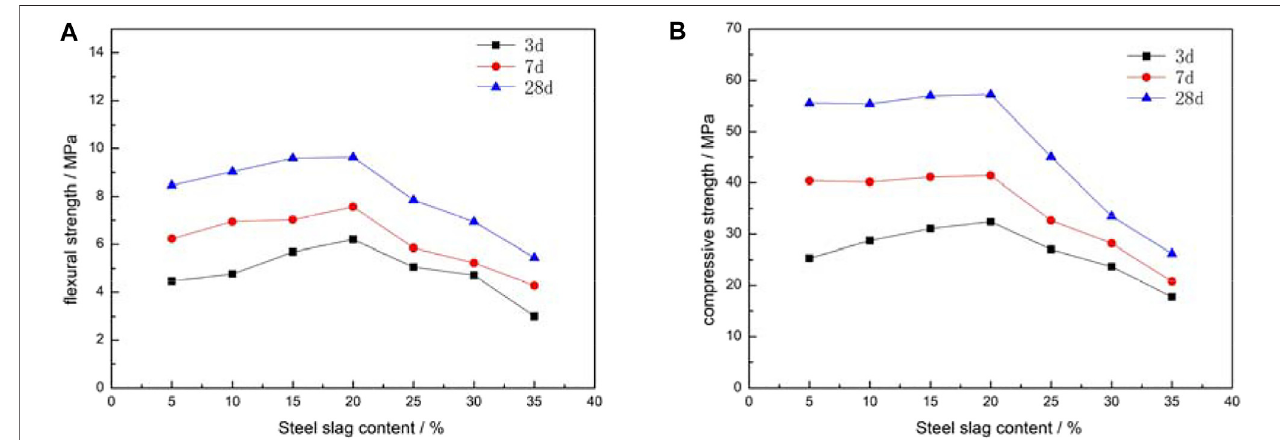
FIGURE 2 | In fl uence of different steel slag content on test blocks strength (A) fl exural strength (B) compressive strength.